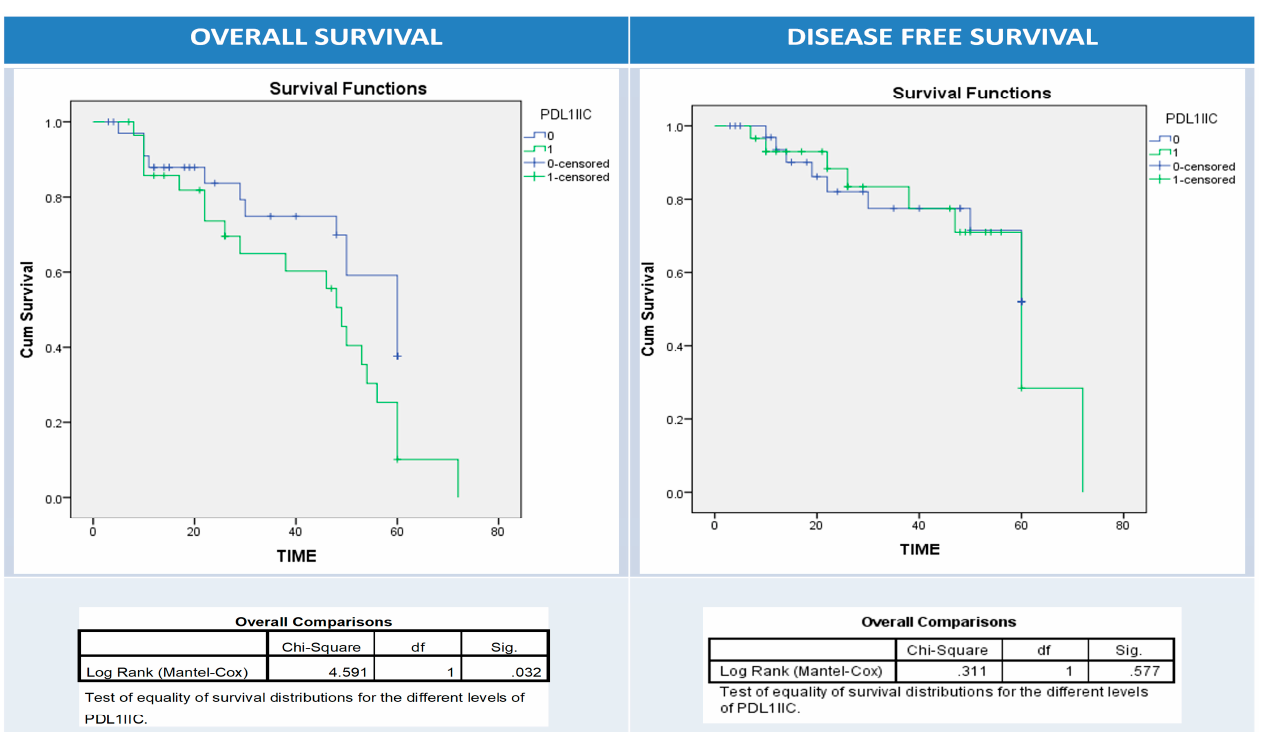
Figure 8. Kaplan–Meier survival curves for overall (right panel) and disease-free survival (left panel) according to intratumor immune cells (IIC) PDL1 expression (0: blue (-ve PDL1 IIC); 1: green (+ve PDL1 IIC)). Log Rank test (Mantel–Cox) was used.